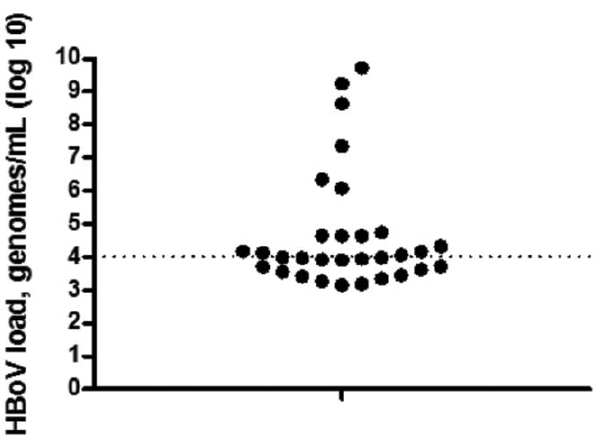
Figure 1. Distribution of human bocavirus (HBoV) viral loads. Thirty one respiratory aspirate samples were tested positive for HBoV. Each sample is represented by a single dot. Viral loads in the nasopharyngeal aspirates ranged from , 500 to 1 6 10 9 copies per mL of sample material. The dotted line indicates the cutoff between the high ( . 10 4 copies/mL) and low ( , 10 4 copies/mL) HBoV viral load groups.